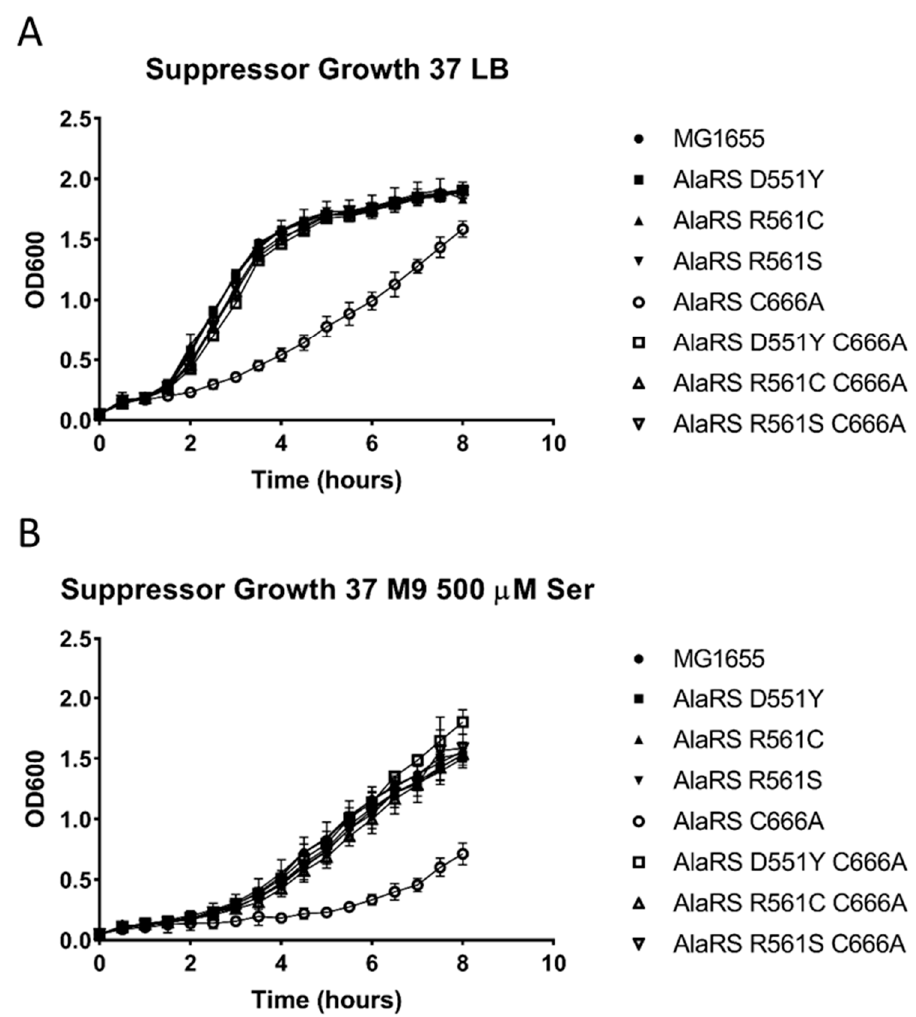
Figure 2. Suppressor mutants alleviate AlaRS C666A-associated growth defects. Suppressor mutants alleviated the AlaRS C666A growth defects in ( A ) LB (Lysogeny broth) and ( B ) M9 minimal media supplemented with non-cognate serine.